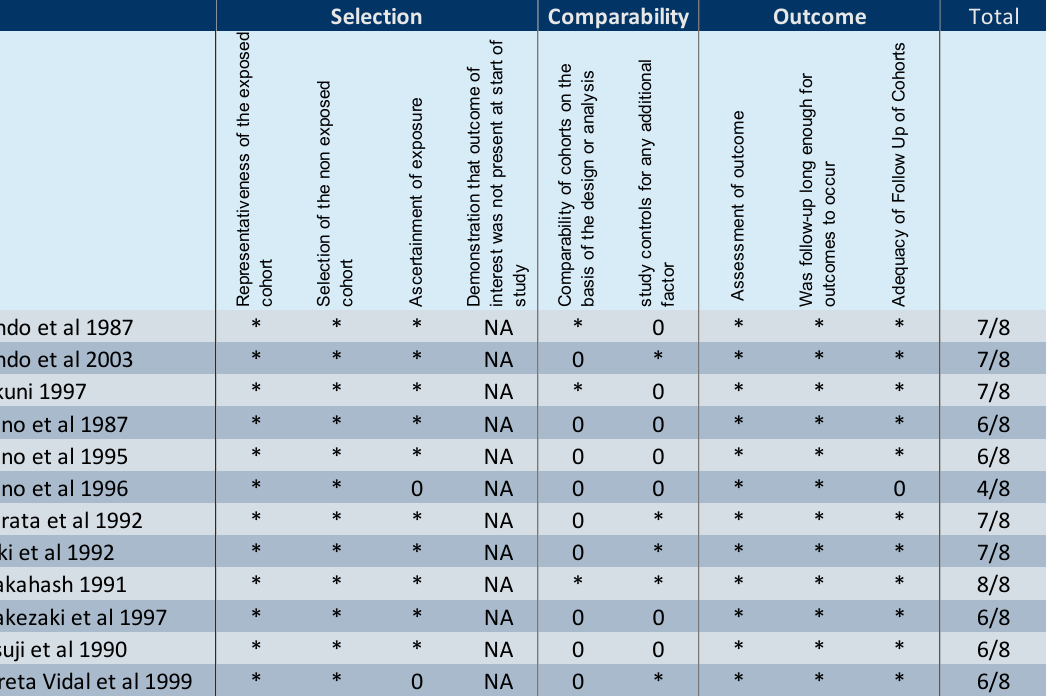
Figure 3. Quality assessment of the studies included in the meta-analysis by the Newcastle– Ottawa Scale. * represents one score [16,28,36–39,44,45,47,51,53,55]